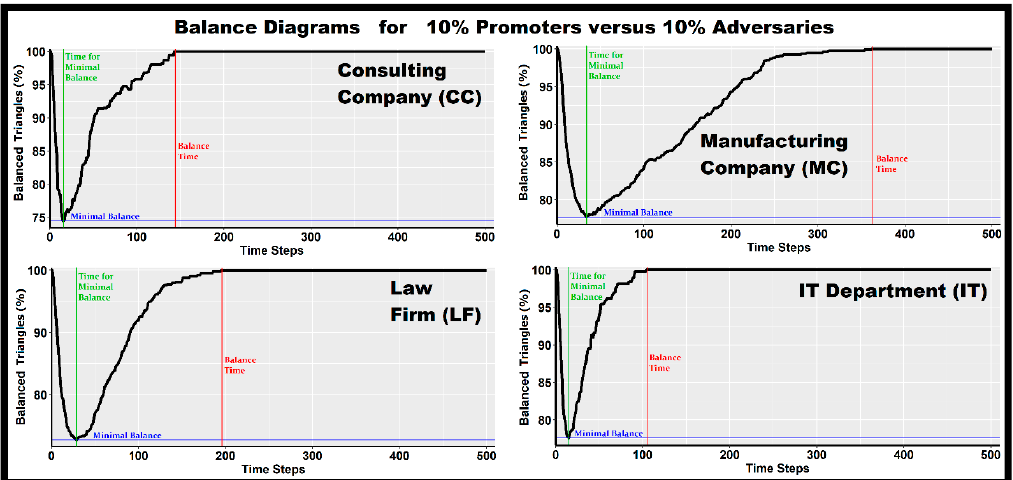
Figure 5. Balance Diagrams for the 4 real organizational networks, corresponding to Figure 4. The blue line indicates the minimal value of the Degree of Balance (Definition 9). This minimal value is called Minimal Balance (MB) . The green line indicates the time required for balance to take this minimal value. This time is called Minimal Balance Time (MBT) . The red line indicates the time required for the re-establishment of balance. This time is called Balance Time (BT) .